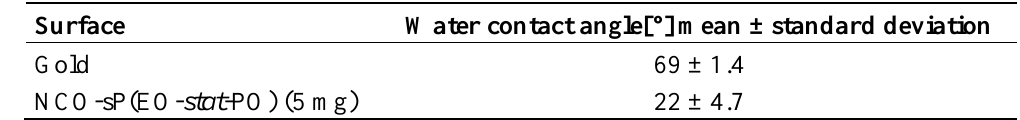
Table 1. Static contact angle measurements on uncoated gold sensors and NCO-sP (EO- stat -PO) coated sensors.